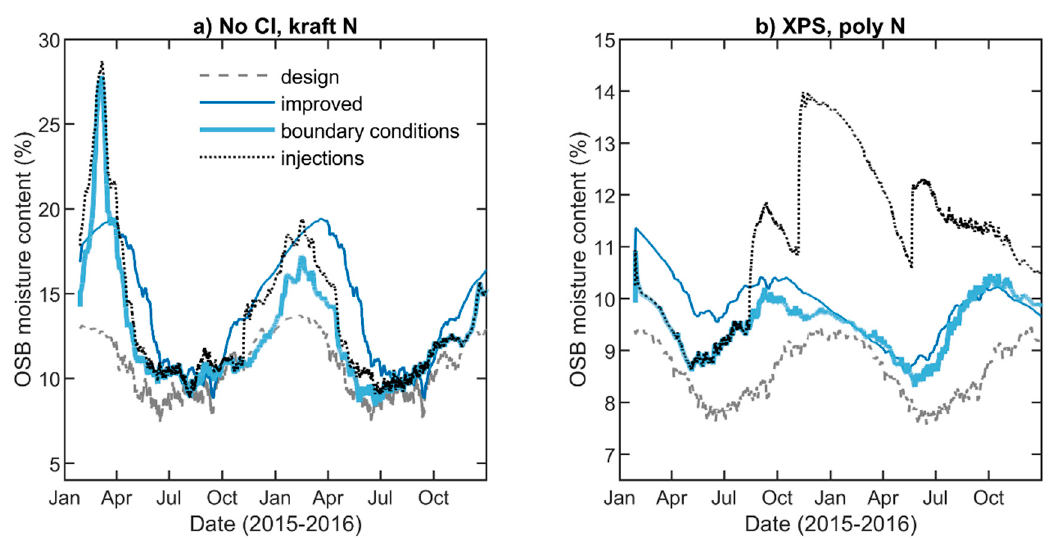
Figure 13. Simulated moisture content of OSB in wall 1 (No CI, kraft N) ( a ), and 7 (XPS, poly N) ( b ), under different model conditions. Note different y-axis scale in ( b ).